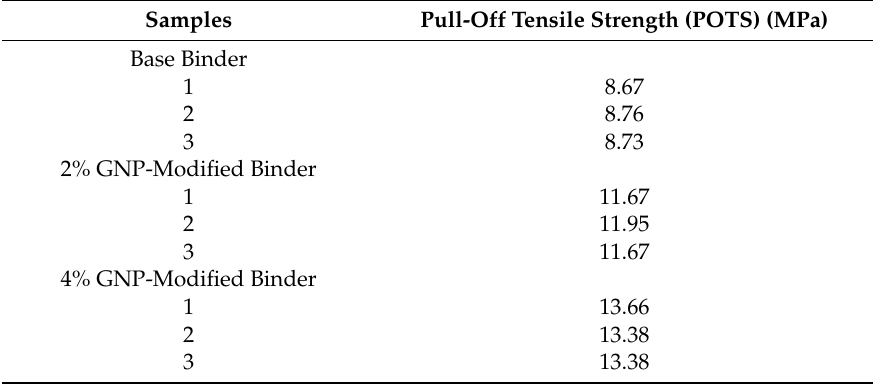
Figure 14. The Pneumatic Adhesion Tensile Test Instrument (PATTI) Assembly. Table 7. The Pull-Off Tensile Strength (POTS) of the binder. GNPs = Graphene Nano-Platelets. Samples